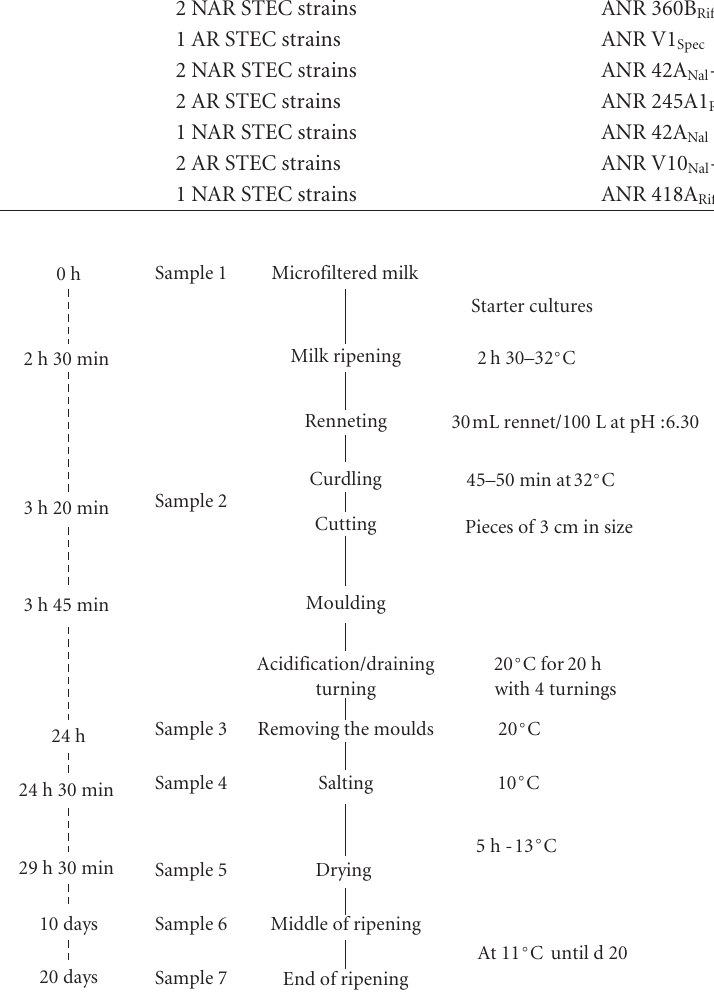
Figure 1: Flowchart for the manufacture of lactic cheeses made with microfiltered